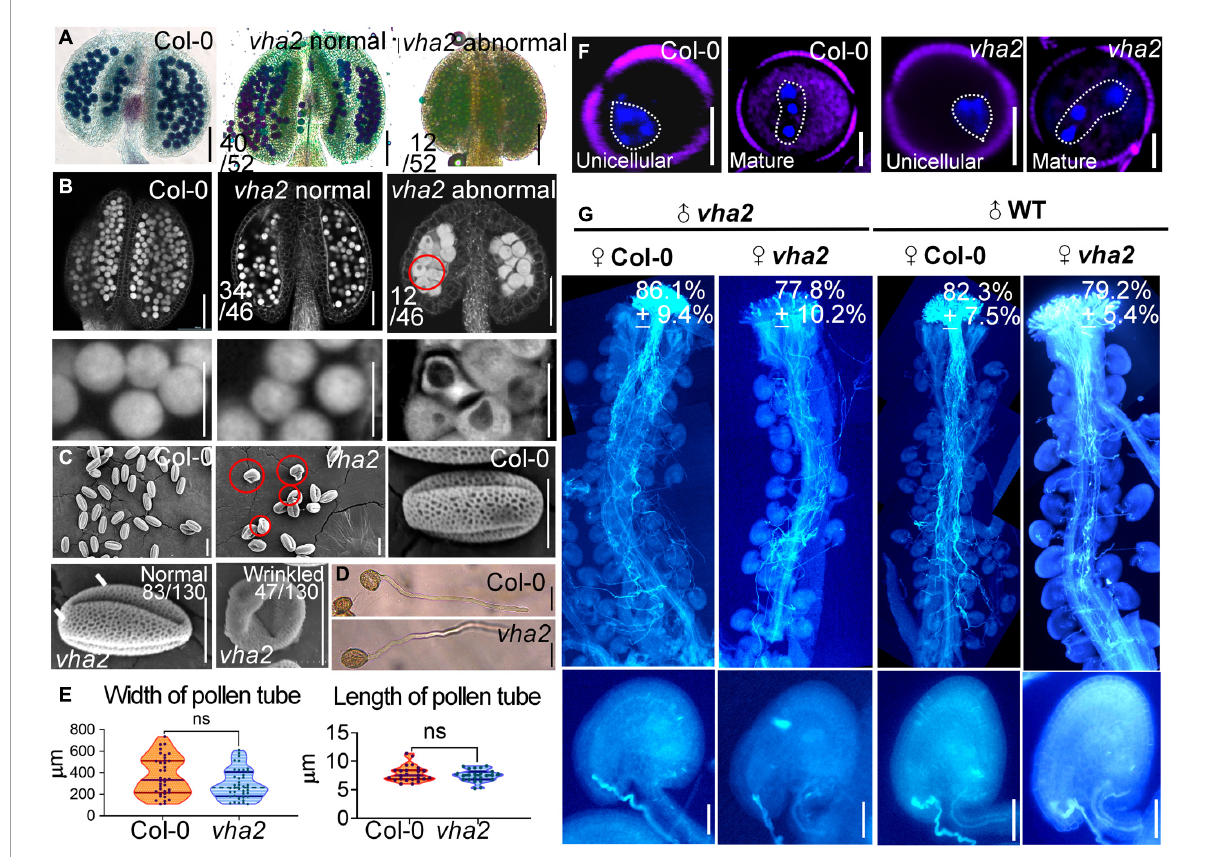
FIGURE3 Lack of V-ATPase affects pollen development. (A) Alexander’s staining of pollen from Col-0 and vha2. The purplish red color indicates viable pollen. Bar = 100 µ m. (B) Anthers visualized by CLSM. Col-0 and vha2 anthers at stage 12. Statistics on the ratio of normal and abnormal flowers in vha2 are shown in each image. Scale bars represent 100 µ m (main image) and 10 µ m (partial enlargement). Red circle indicates the pollen grain that should have matured was stagnant at PMI stage with big vacuole. (C) SEMs observation on pollen grains from Col-0 and vha2. The scale bar is marked in each image. Bars = 10 µ m. (D) A tetrad of mature pollen of Col-0 and vha2 from in vitro pollen germination. Bars = 50 µ m. (E) Quantitative analysis of pollen germination. Results shown are means ± standard errors (SE, n = 3). In total, 30 tetrads were examined for each genotype. (F) DAPI staining of unicellular and mature pollen grains from Col and vha2. The purple part is the outline of pollen grains stained with FM4-64. Bars = 5 µ m. (G) Aniline blue staining of Col-0 and vha2 pistils at 24 h after pollination (HAP) with Col-0 and vha2 pollen. The whole pistil was overlaid by three overlapping images with Photoshop (Adobe). Numbers in (G) are quantification of targeted ovules out of total ovules. Results are means ± SD ( n = 15). Bars = 20 µ